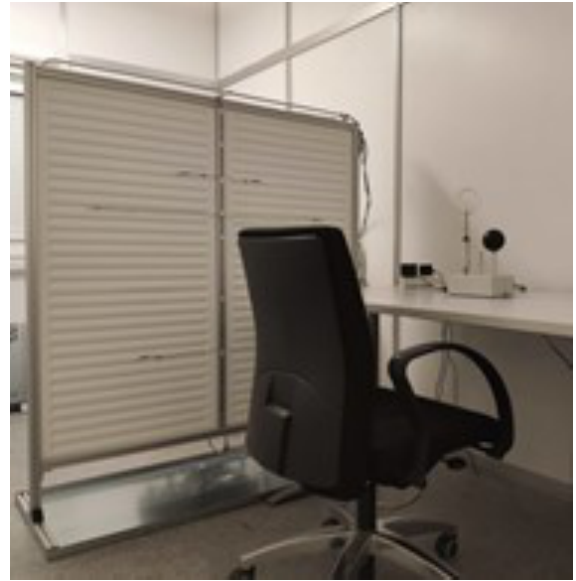
Figure 1. Test room equipped with a cooling